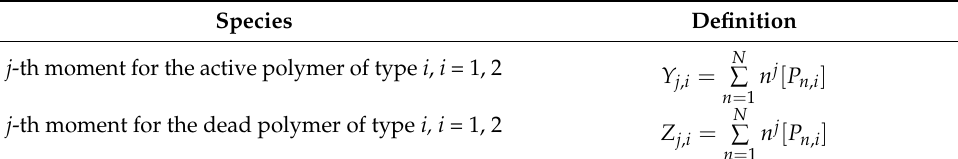
Table 2. Definition of